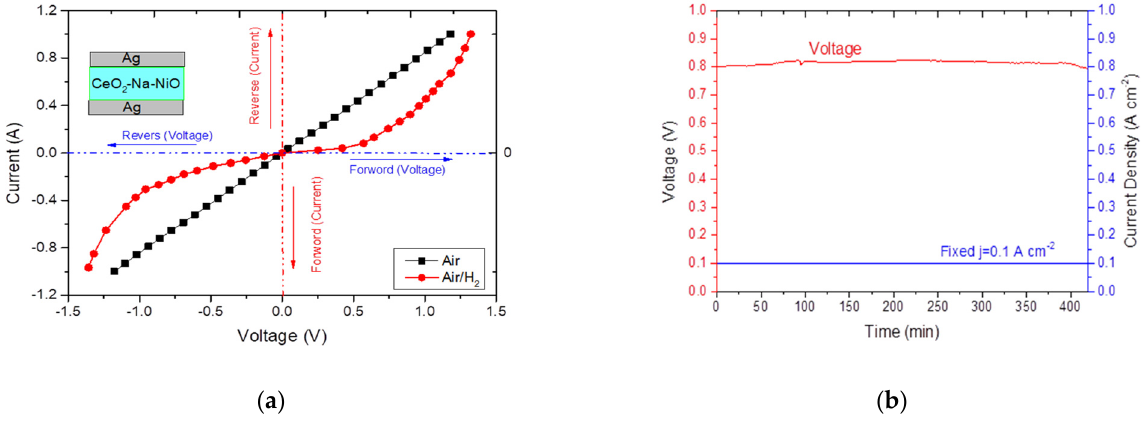
Figure 9. ( a ) the I − V characteristics under the bias measurements of the CeO 2 -Na-NiO heterostructure in air/air and in H 2 /air environments, and ( b ) the durability test result of the CeO 2 -Na-NiO sample at current density of 0.1 A cm − 2 at 530 °C.